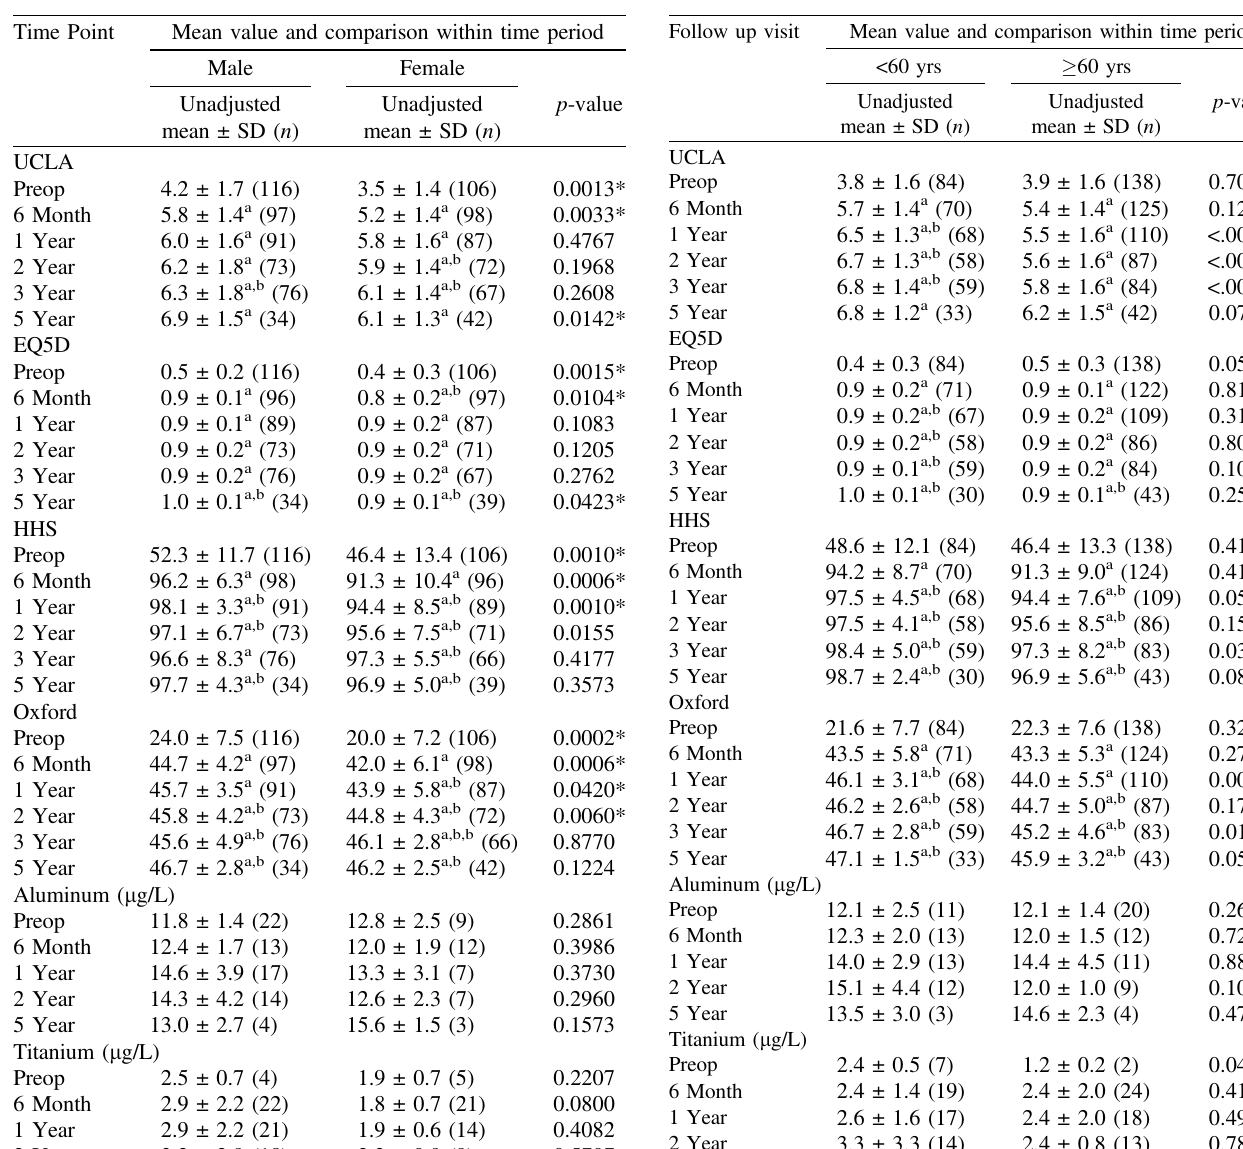
Table 3. Subgroup analysis by gender; difference between time point was performed with Bonferroni adjusted p -value.